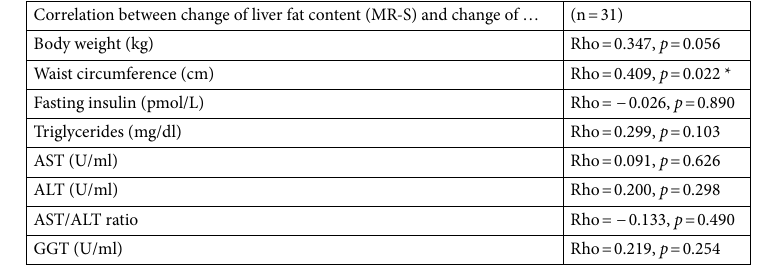
Figure 3. Correlation analysis with changes of liver fat indices and IHL; FLI = fatty liver index, HSI = Hepatosteatosis Index, IHL = intrahepatic lipids, NAFLD-LFS = non-alcoholic fatty liver disease-liver fat score; ( a ) IHL ~ FLI; rho = 0.342. p = 0.069; ( b ) IHL ~ NAFLD-LFS; rho = − 0,058, p = 0.765; ( c ) IHL ~ HSI; rho = − 0.049, p = 0.800.